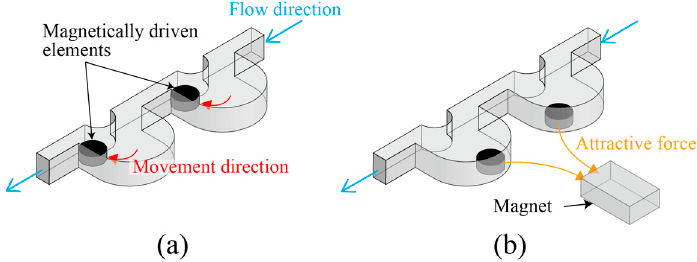
Figure 4. Driving method of microvalve array device at ( a ) close and ( b ) open state.